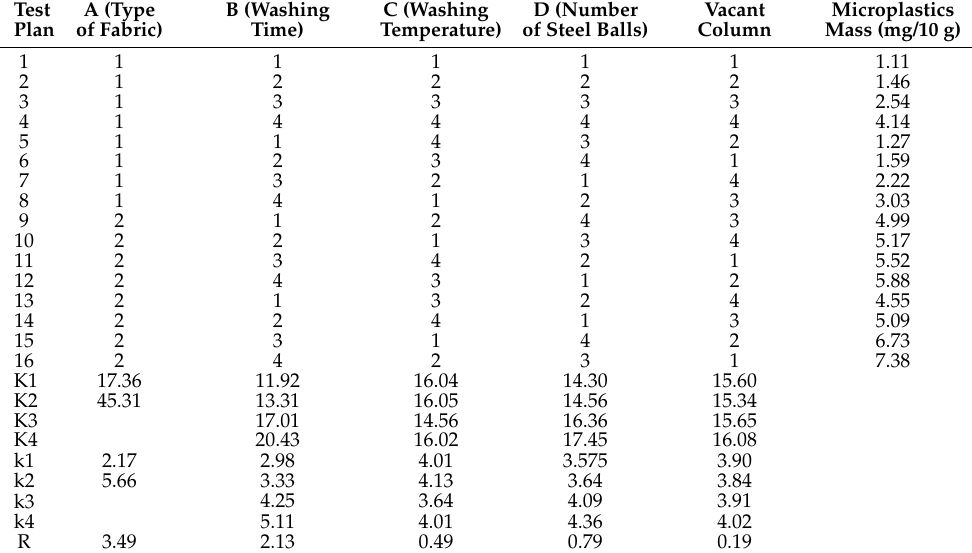
Table 7. Test results and visual